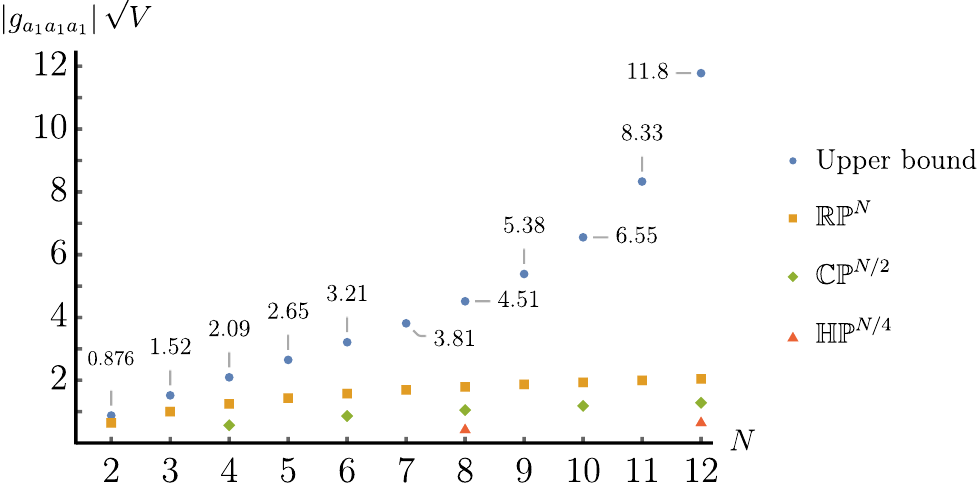
jp Figure 7 . Upper bounds on j g a V for closed Einstein manifolds with R (cid:21) 0 and 1 a 1 a 1 N = 2 ; : : : ; 12, assuming that (cid:21) a (cid:21) (cid:21) a and (cid:21) I (cid:21) 0. The square, diamond, and triangular mark- 1 ers correspond to the lightest nontrivial zonal spherical functions on RP N , CP N= 2 , and HP N= 4 , respectively, with their standard